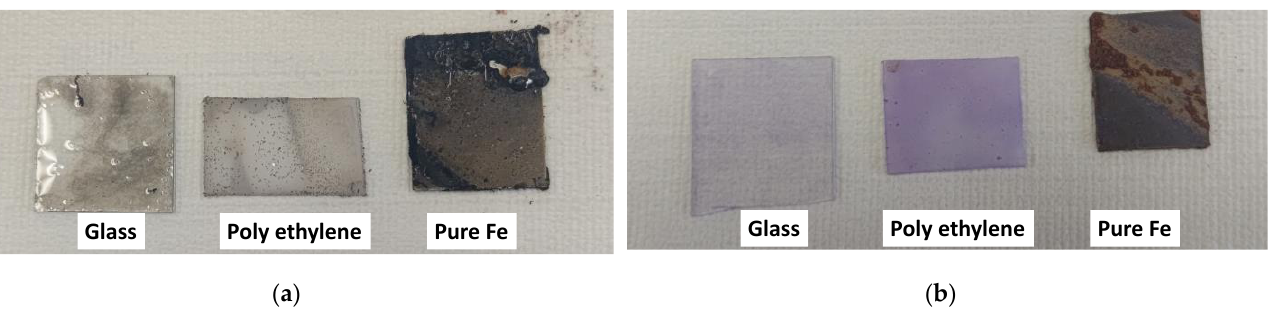
Figure 10. The results of biofilm detection. ( a ) Ag deposition; ( b ) Crystal violet dye staining.